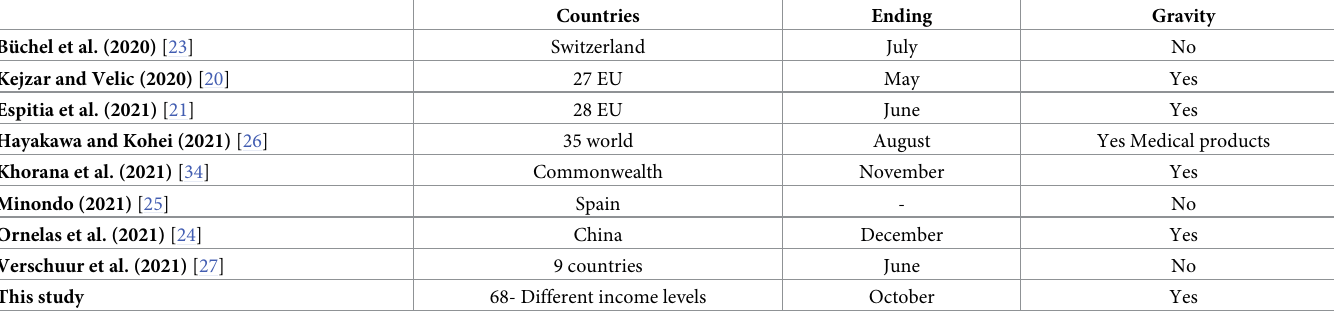
Table 1. A compilation of studies covering COVID-19 impacts on trade using monthly data. Countries Ending